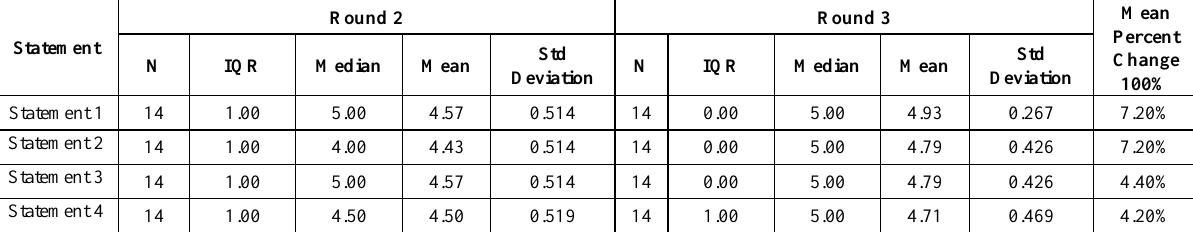
Table 5: Statistical analysis of Round 2 and 3 – NDCDB‘s role in land-based analysis